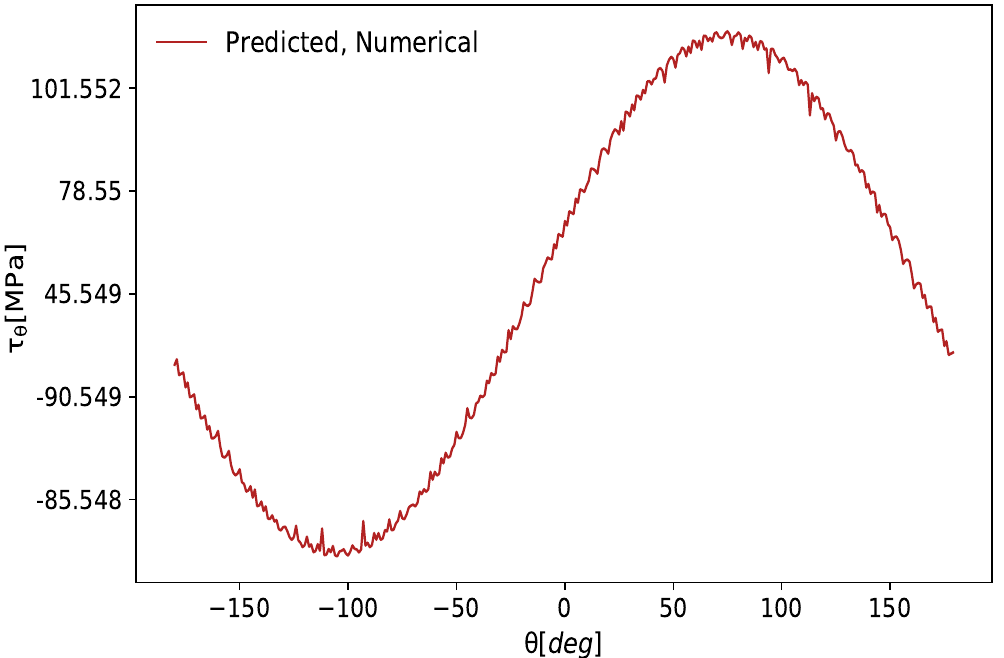
Figure 16. Circumferential stress distribution in the rolling gap for given number of cyclic loads